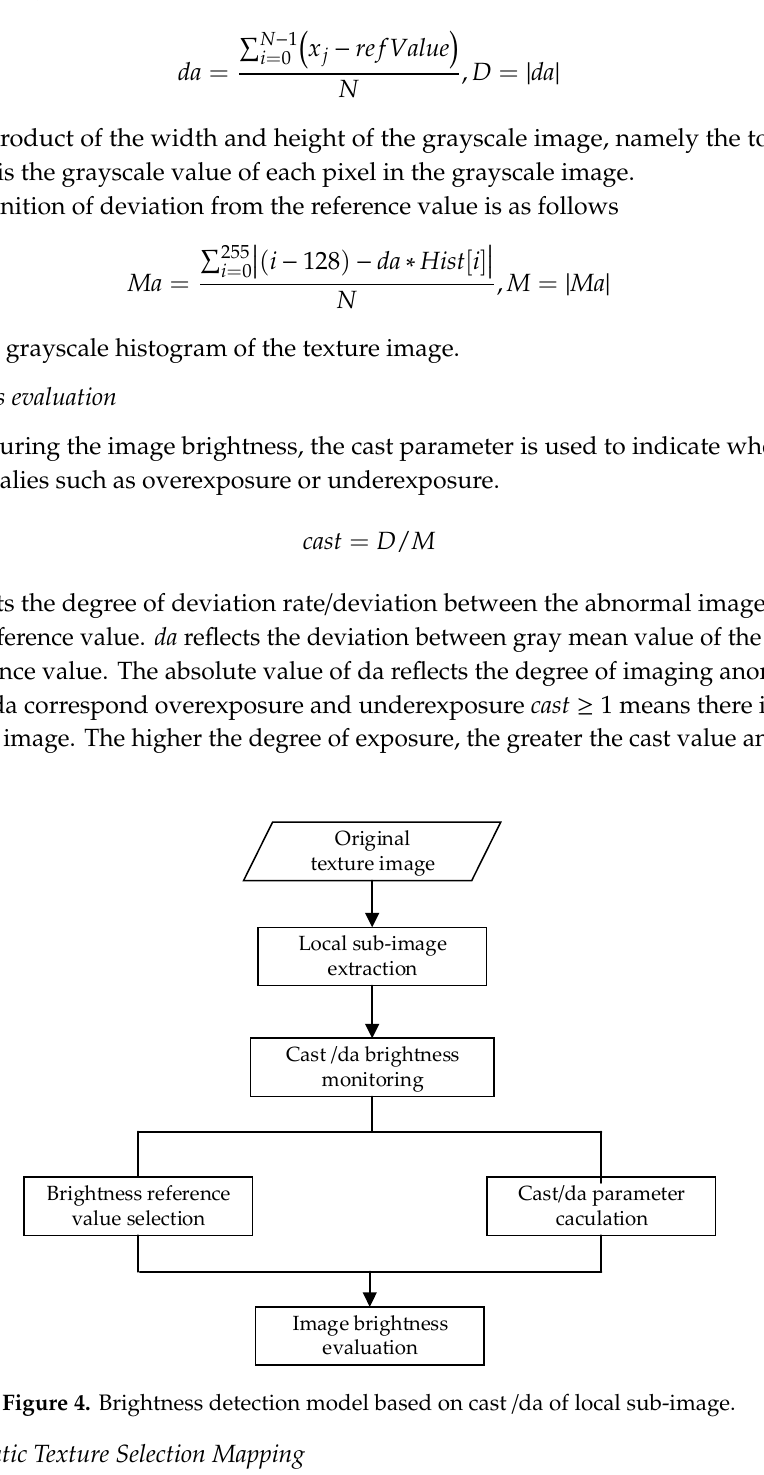
Figure 4. Brightness detection model based on cast /da of local sub-image.